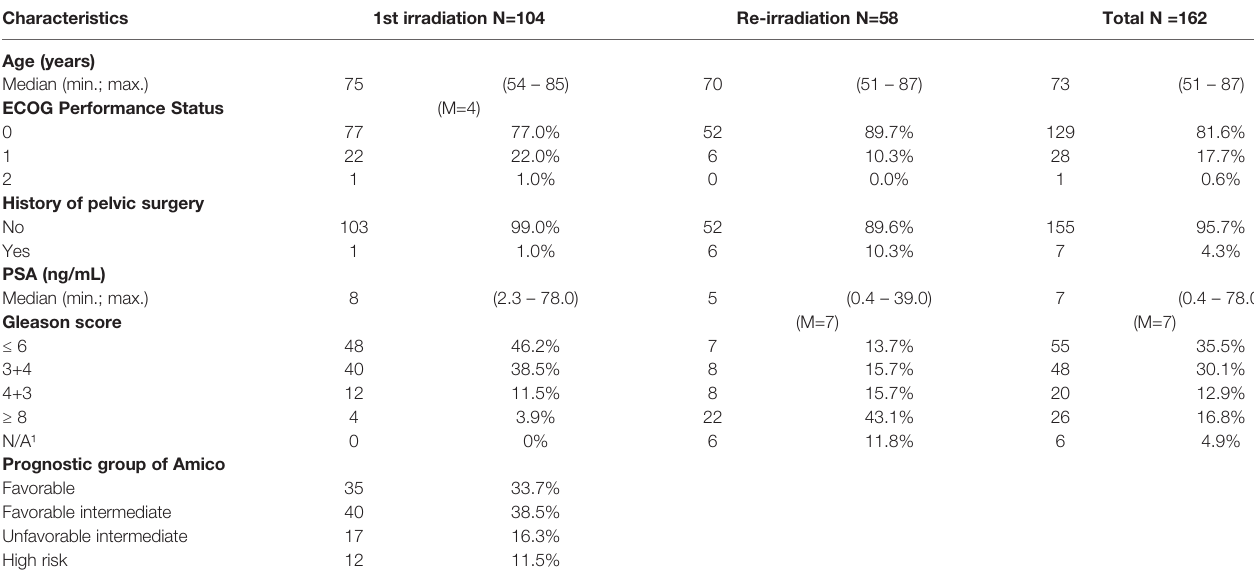
TABLE 1 | Patient and tumor characteristics at the time of SBRT (N=162).